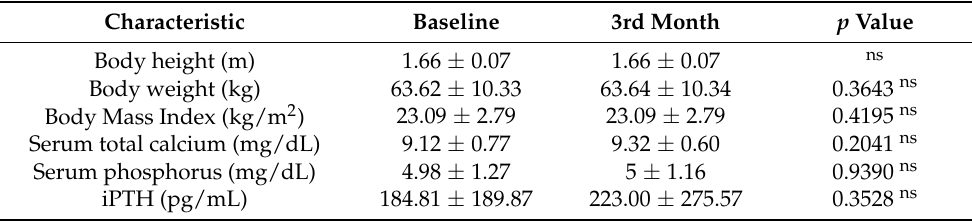
Table 2. Comparisons of body mass index, serum ions, and serum intact parathyroid hormone at baseline and at the third month after daily EPA supplementation in hemodialysis patients (mean ± SD).